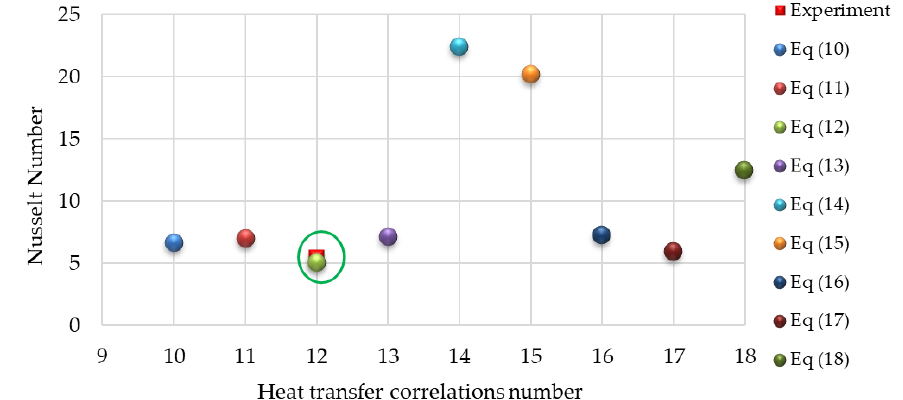
Figure 10. Correlation for empty channel (flow rate = 3 L/m).